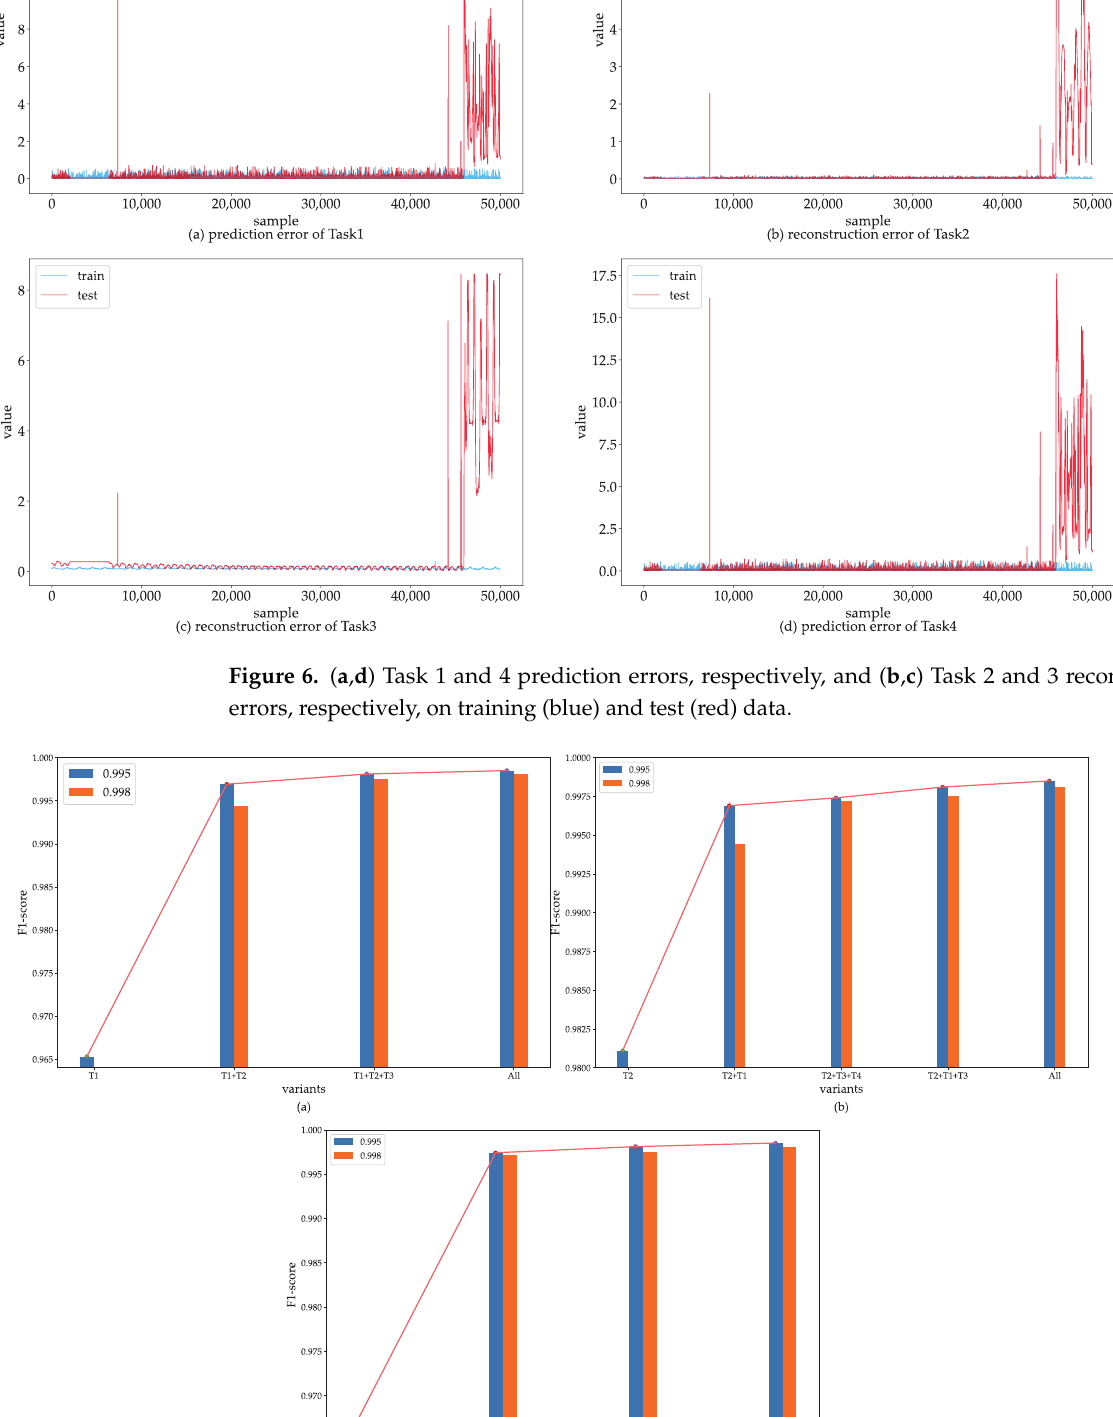
Table 4. Ablation study results.